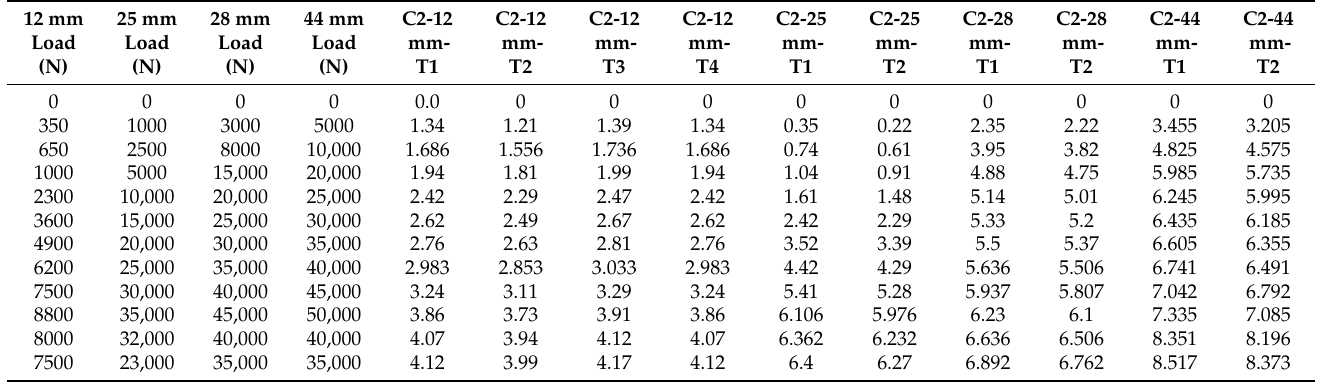
Table A2. Peak force and associated displacement for punch test cell 2